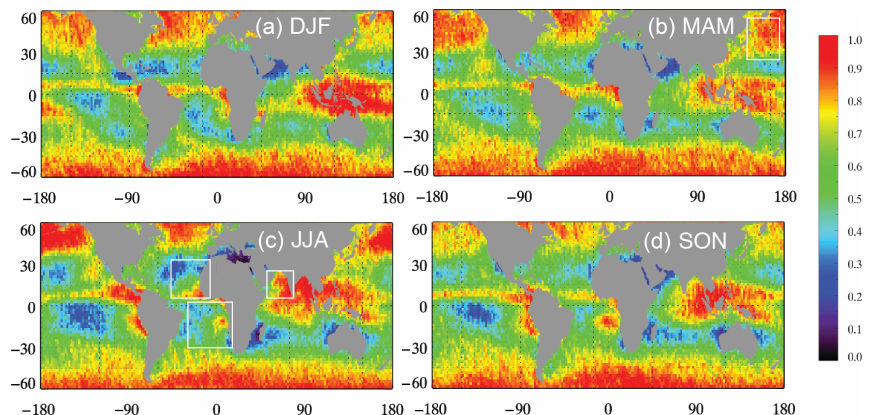
Figure 1. Multiyear seasonal mean total cloud fraction in (a) DJF, (b) MAM, (c) JJA and (d) SON derived from 8 years of daytime CALIOP observations.